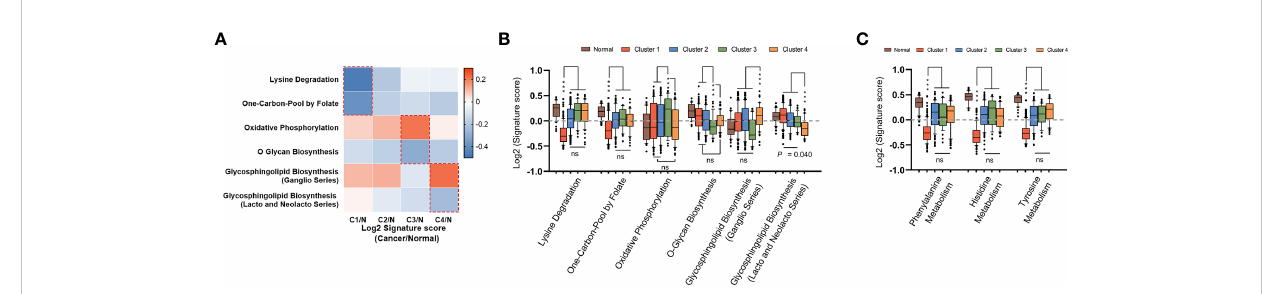
FIGURE 4 Identi fi cation of unique metabolic characteristics in each subtype. (A) Heatmap displaying the GSVA score of which pathway has exclusivity signi fi cant difference between a subtype and normal control group. Pathways that showed signi fi cant difference in only one group were marked with dotted box, and were shown in box plots of (B, C) , respectively. (ns: not signi fi cant, ***: P <